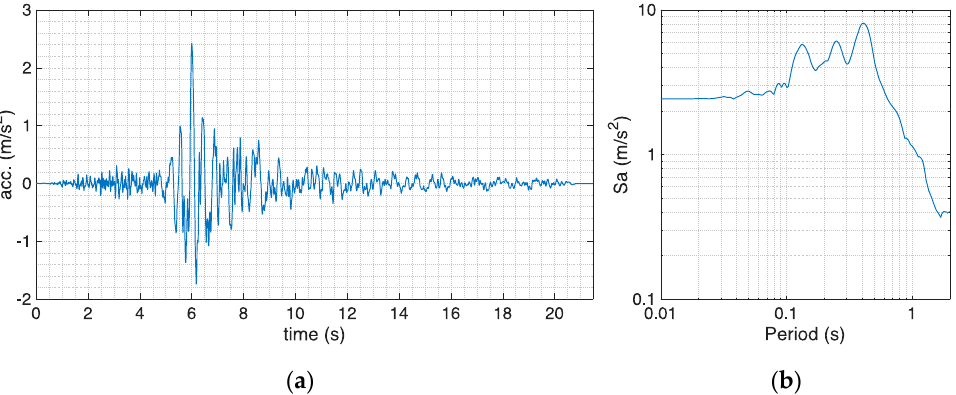
Figure 7. East-West horizontal component of record “Accel outcrop” (Central Italy) in terms of acceleration ( a ) history and ( b ) response spectrum.